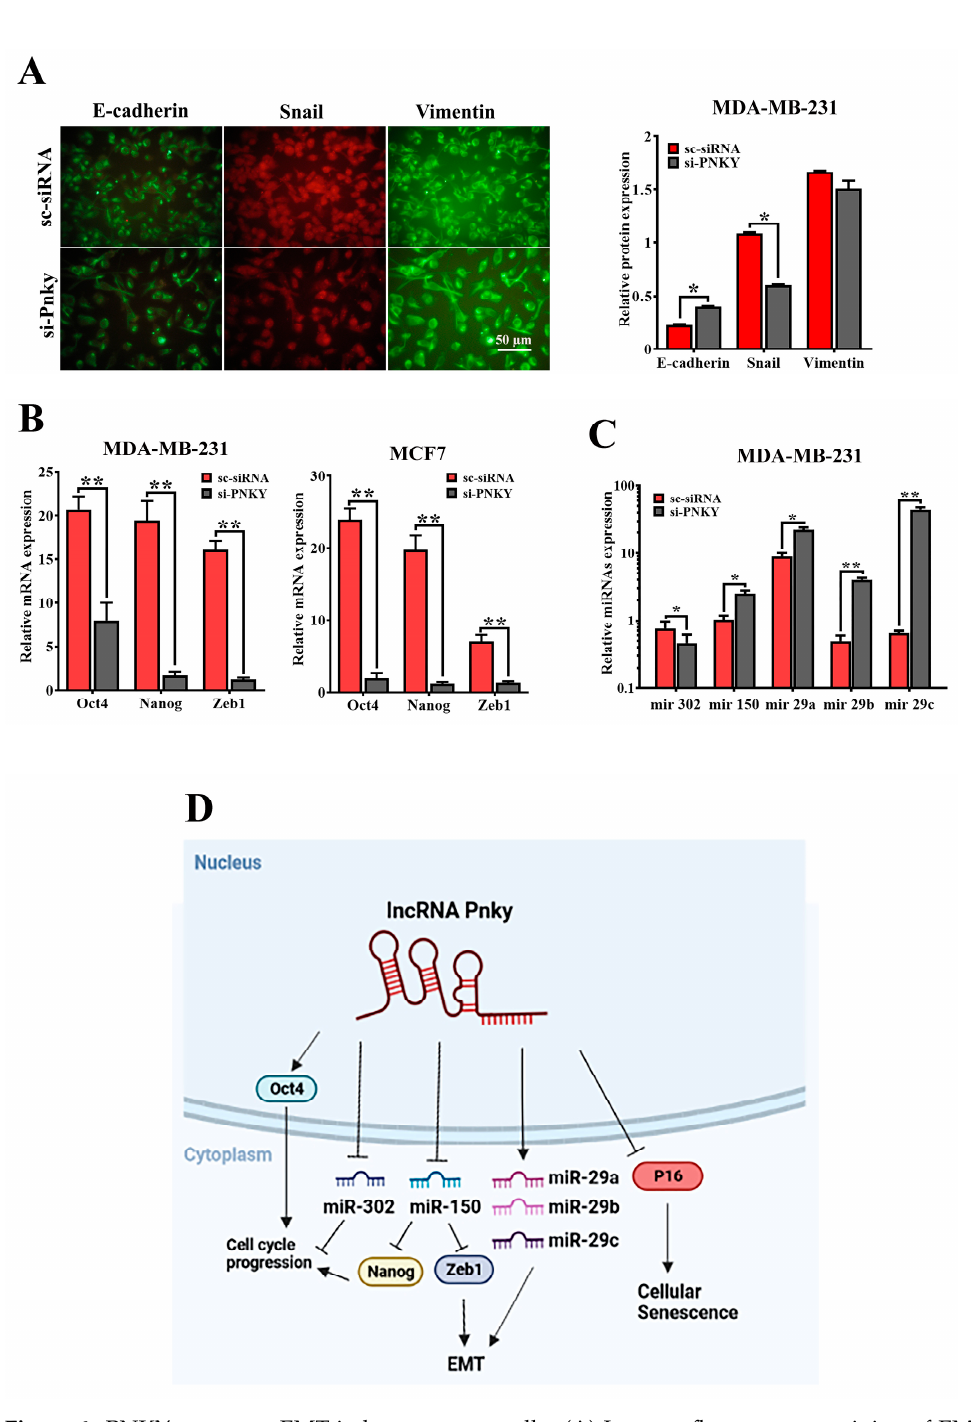
Figure 6. PNKY promotes EMT in breast cancer cells. ( A ) Immunofluorescence staining of EMT markers revealed that PNKY suppression upregulates epithelial marker (E-Cadherin) and downregulates mesenchymal markers (Snail and Vimentin) in MDA-MB-231 cells ( B ) Oct4/Nanog, stemness factors, and Zeb1, a well-defined EMT marker, were significantly downregulated following PNKY suppression. ( C ) The expression levels of hsa-miR-302, hsa-miR-150, hsa-mir-29a, hsa-mir-29b, and hsa-mir-29c were altered following PNKY silencing in the MDA-MB-231 cell line. ( D ) Schematic diagram illustrates the suggested PNKY function in breast cancer. The values shown represent the mean ± SE. * p value < 0.05, ** p value < 0.01.